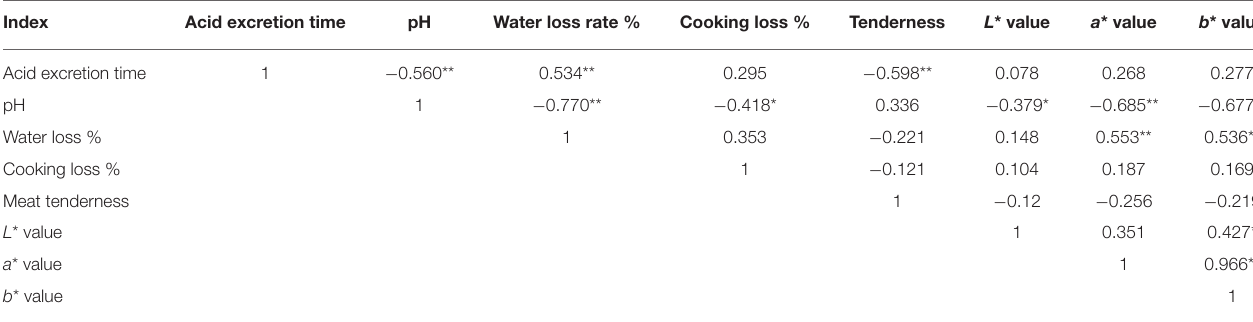
TABLE 6 | Correlation analysis of meat quality index in Wenshan beef in the process of